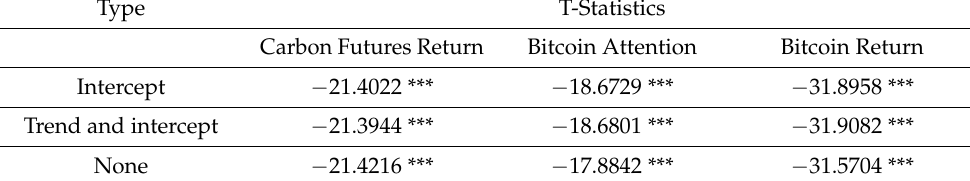
Table 1. Descriptive statistics and the ADF stationary test of the interested time series.